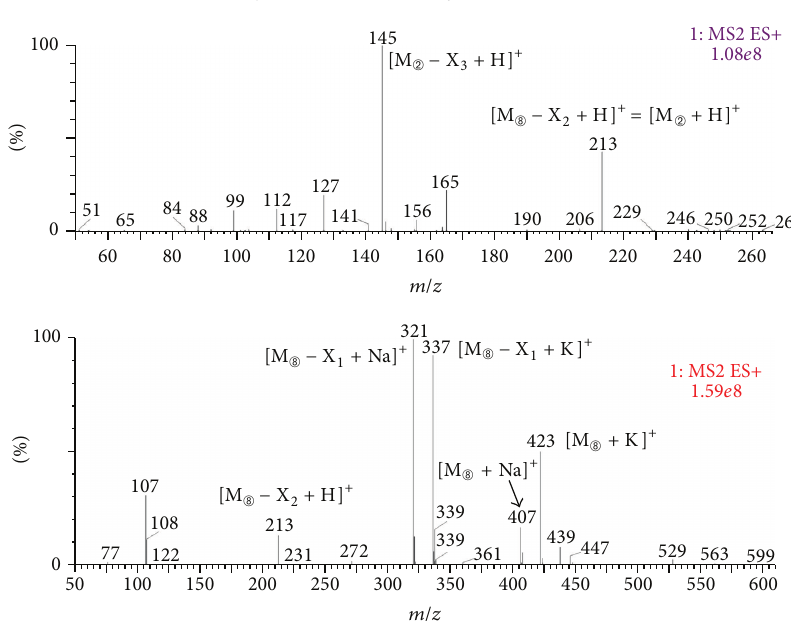
Figure 6: The analysis results of the unknown compounds B , H , and 0 .